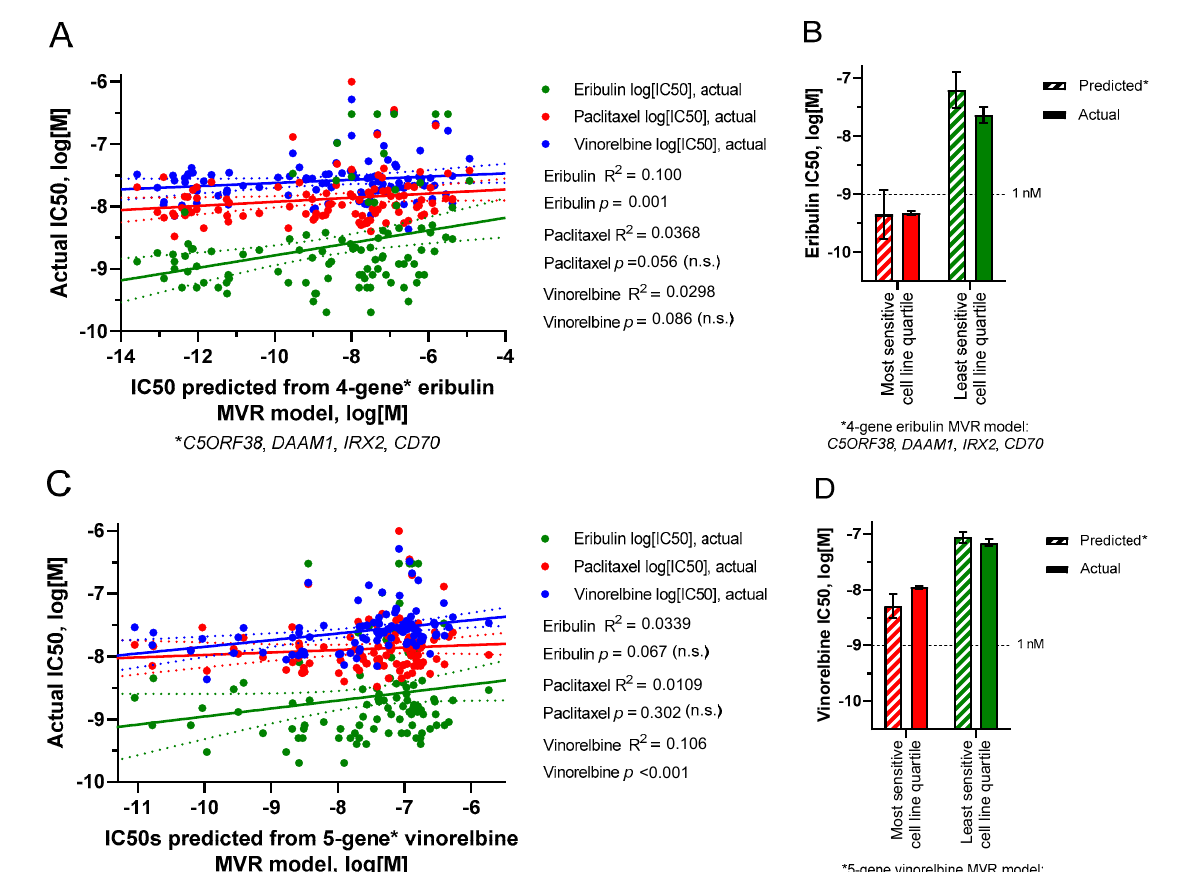
Figure 5. Predicted versus actual IC50s based on limited gene MVR models. ( A , B ) predicted IC50s were derived from a 4-gene subset ( C5ORF38 , DAAM1 , IRX2 , CD70 ) of the 9 eribulin UFGs. ( C , D ) predicted IC50s were derived from a 5-gene subset ( EPHA2 , NGEF , SEPTIN10 , TRIP10 , VSIG10 ) of the 13 vinorelbine UFGs. ( A , C ) linear regressions of predicted versus actual IC50s for all 100 cell lines. ( B , D ) predicted versus actual mean IC50s (±SEM) for the most sensitive and least sensitive cell line quartiles as defined in Figure 1. For ( A,C ), linear regression lines (solid) are shown together with their corresponding 95% confidence bands (dotted). For visual comparison, scales of x- and y-axes were kept the same between both panels here and Panels ( A,B ) of Supplemental Figure S2. No statistically significant differences were found between predicted and actual quartile mean IC50s in ( B ) or ( D ).